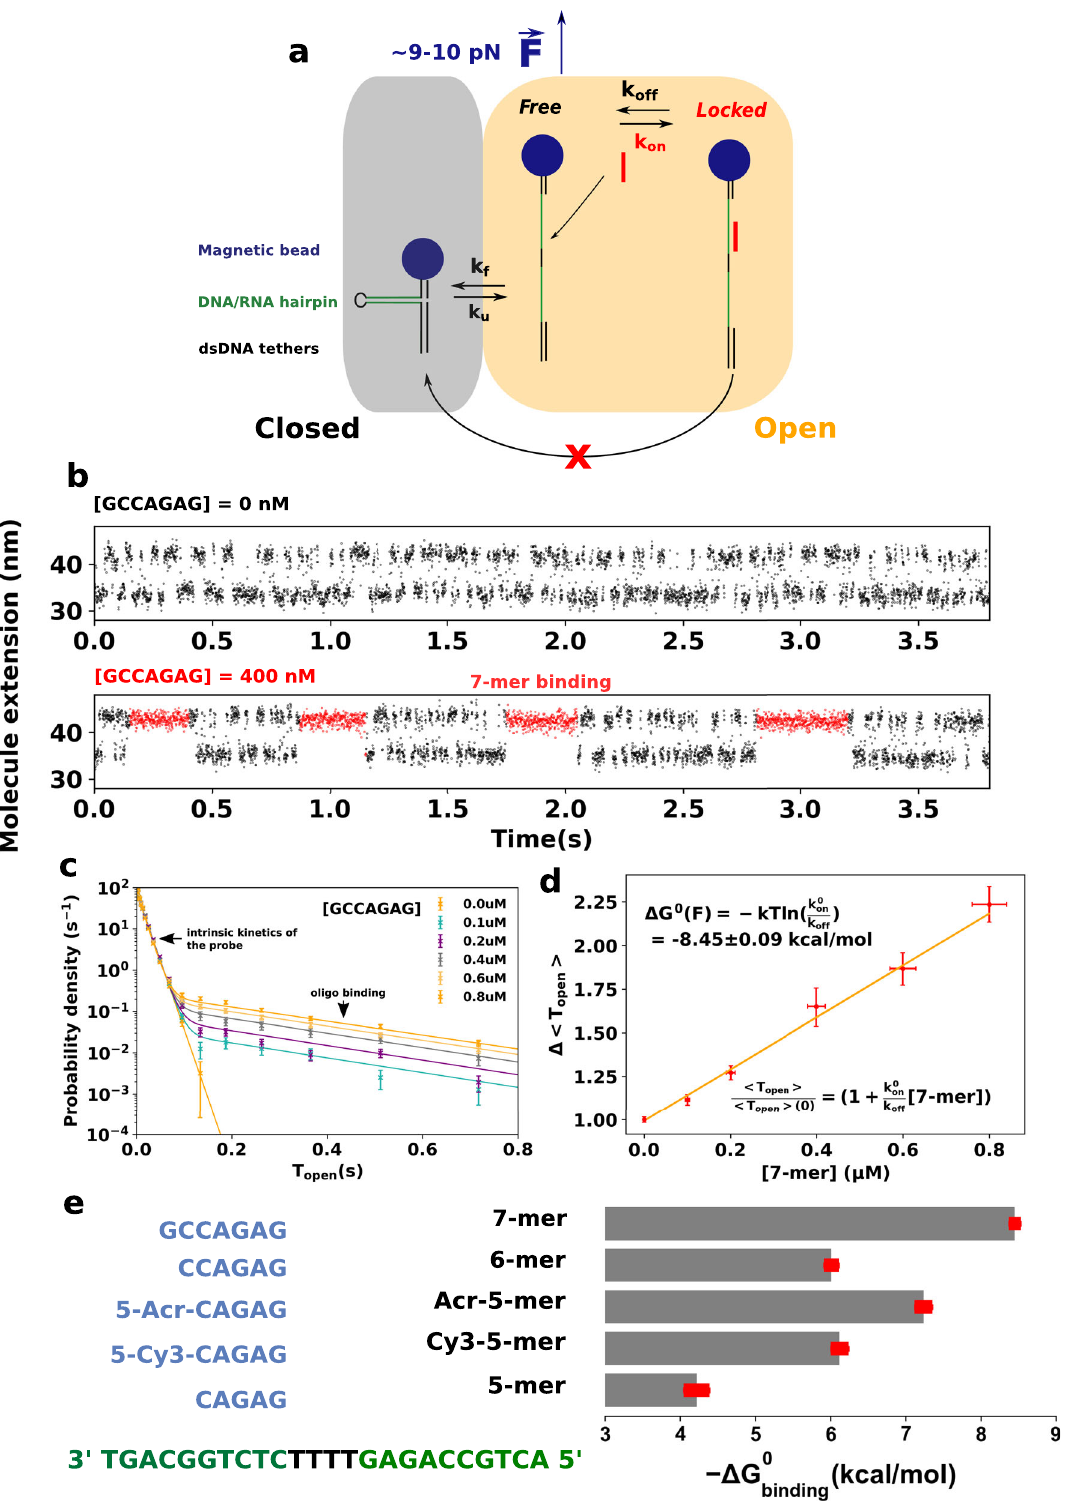
time RecQ- Δ C in this con fi guration (Supplementary Figure S4), while the typical time spent by the free hairpin in the closed state is divided by a factor 8. Interestingly, RecQ- Δ C also keeps the fork closed in the presence of a 7-base gap on the nascent lagging strand (Fig. 4), indicating that fork gripping by the enzyme is not dependent on the interaction with the free 5 ′